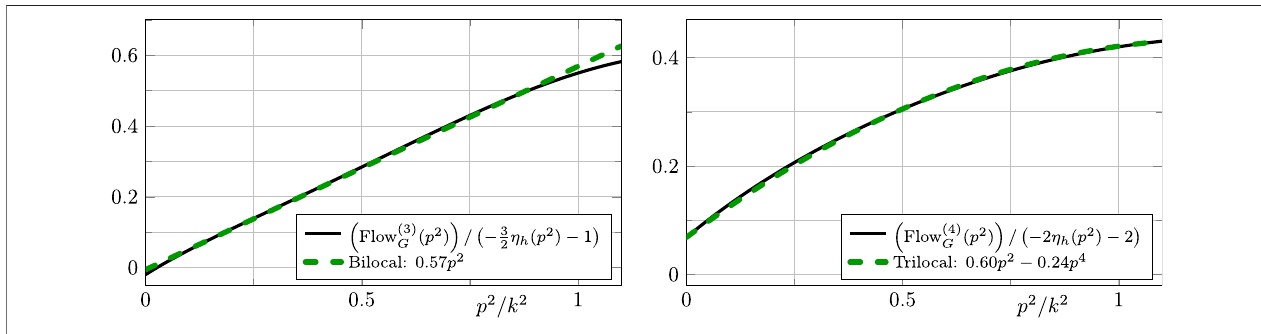
FIGURE 8 | Momentum dependence of the transverse traceless graviton three- and four-point couplings obtained by normalizing the vertex fl ow with η ( p 2 ) − n + 2 (cid:30) . The graviton three-point coupling (left panel) is well described with a linear p 2 function in the momentum range 0 ≤ p 2 ≤ k 2 . This momentum (cid:29) − n h 2 dependence stems from the R tensor structure. The absence of a p 4 behavior implies that the R 2 μ ] tensor structure is suppressed. On the other hand, the graviton four- point coupling (right panel) shows a clear p 4 behavior, which is associated with R 2 tensor structure. The fi gures are taken from